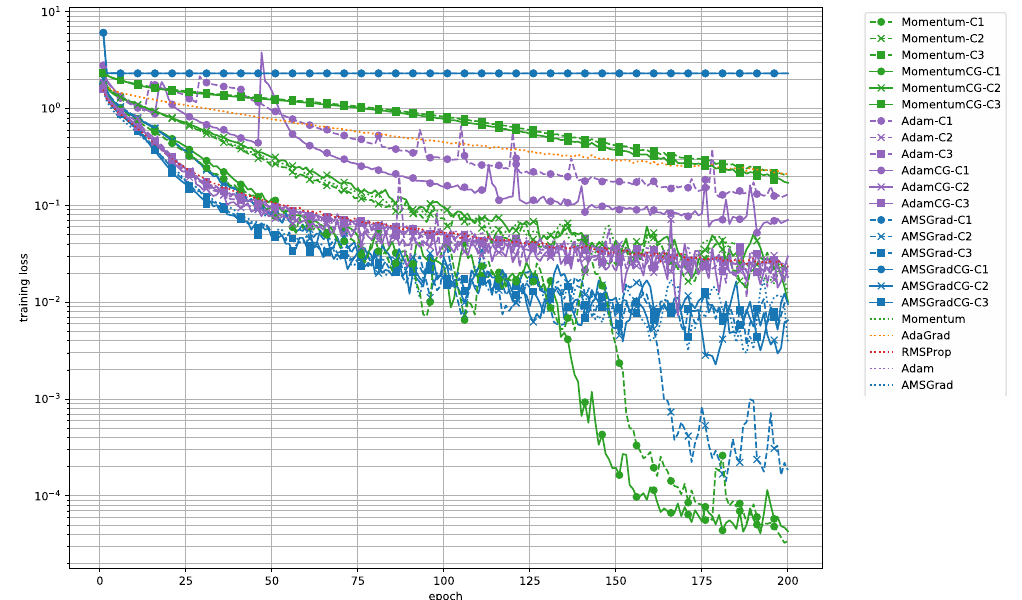
Figure 1. Loss function value versus number of epochs on the CIFAR-10 dataset for training